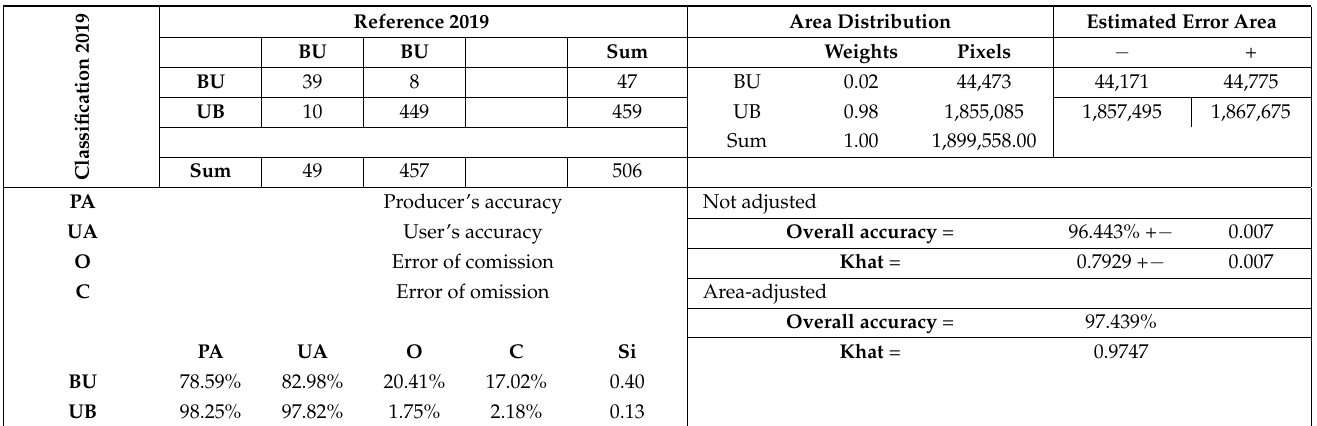
Table A2. Confusion matrices for 2019. BU: burned, UN: